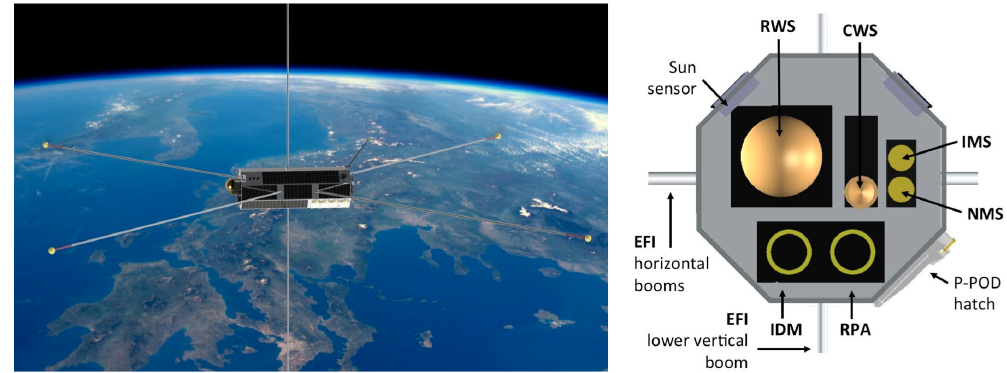
Figure 12. Spacecraft observation geometry: Daedalus s / c with extended field booms; four electric field booms are arranged in an X forma- tion in the along- and cross-track plane, and two booms are aligned vertically (left). Ram direction instrumentation